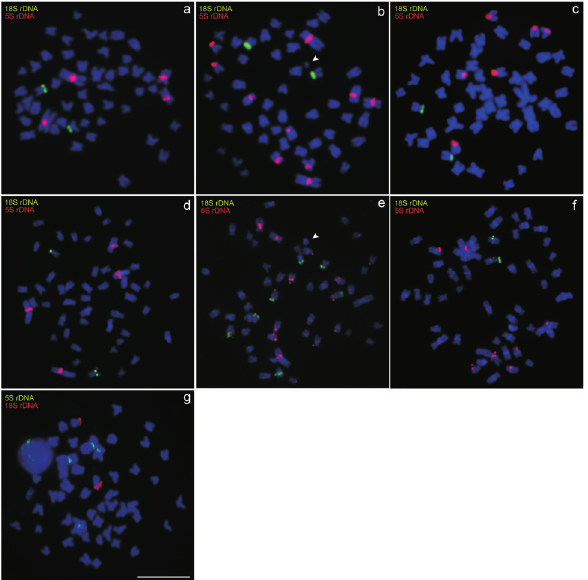
Figure 4 - Metaphases mapped by double-FISH with 18S and 5S rDNA probes in: (a) M . cosmops ; (b) M . forestii ; (c) M . nigromarginata ; (d) Moenkhausia sp. n . ; (e) M . oligolepis (Xapuri River); (f) M . oligolepis (Corredeira Stream), and (g) M . oligolepis (Sangue River). The B chromo- somes are indicated by arrowheads. Scale bar = 10 (cid:2) m.